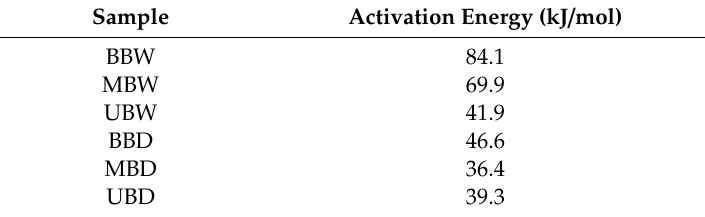
Table 4. Activation energy of thermo-oxidation process of okra fibers (standard deviation